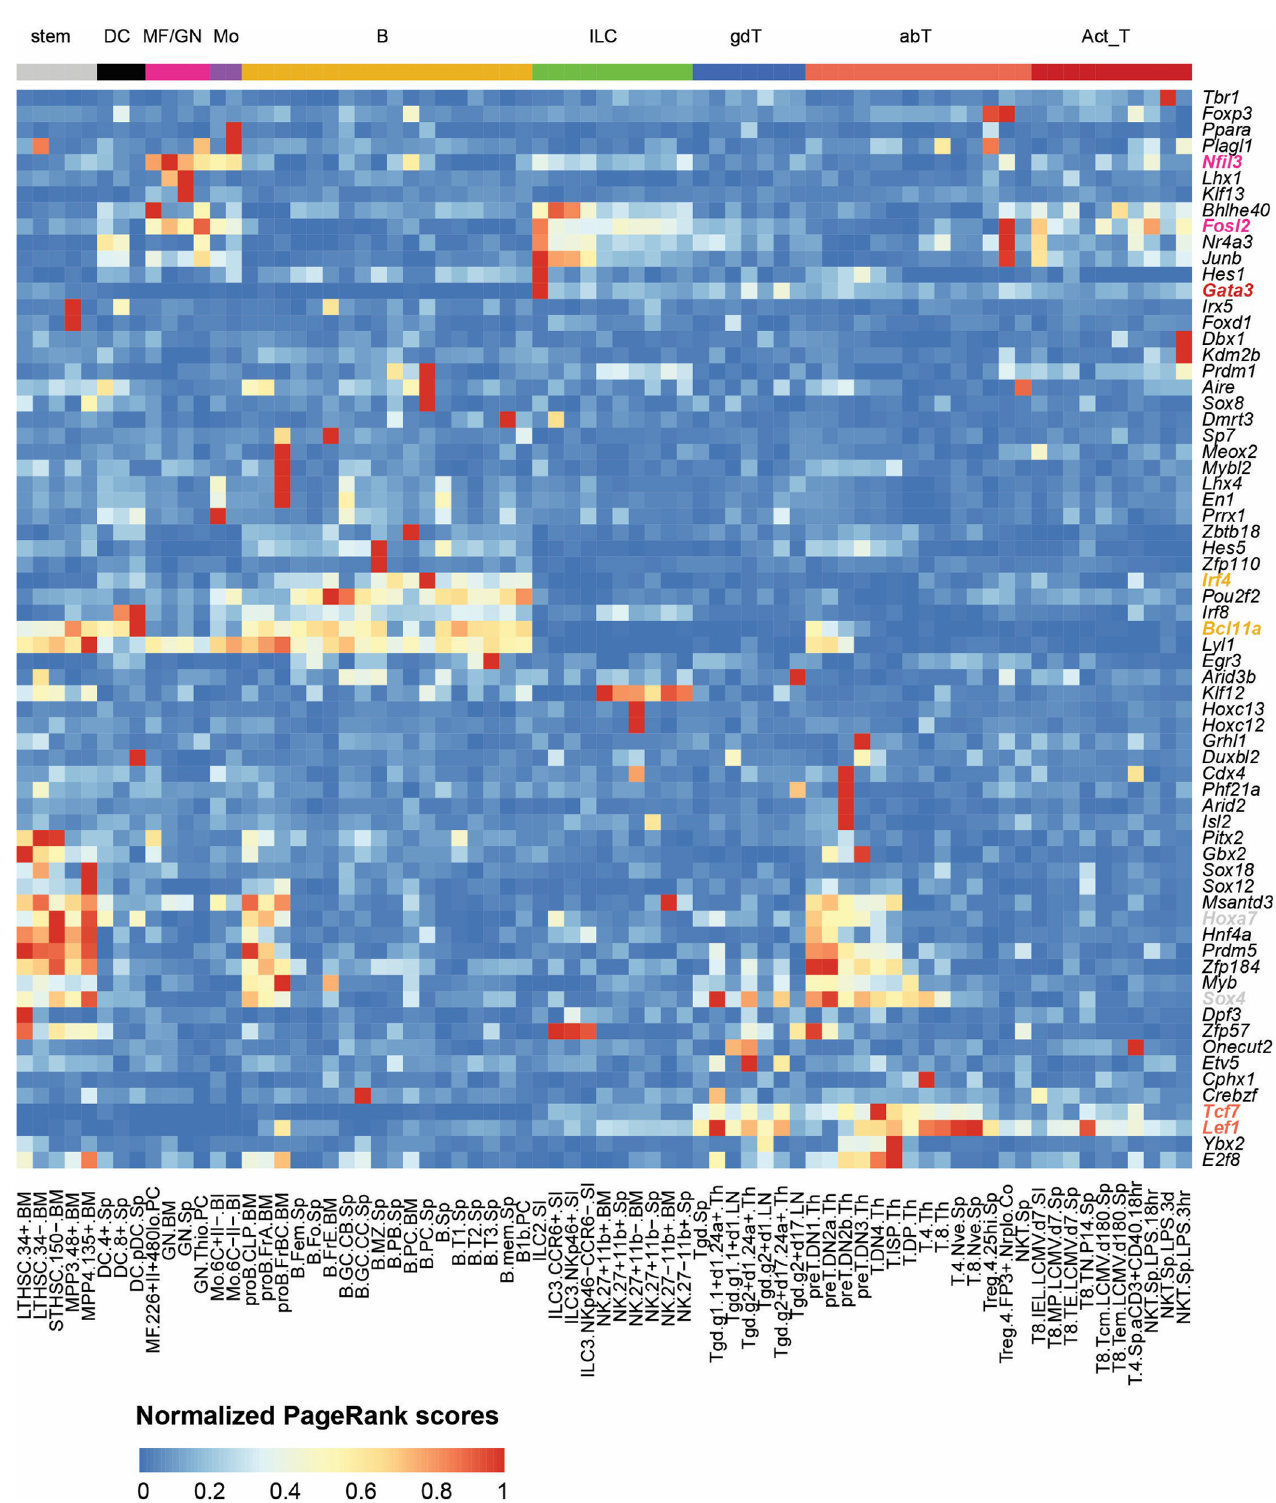
Fig 2. PageRank score is a great indicator of cell specificity. PageRank scores heatmap of 59 cell-specific TFs across 73 cell types. TFs in rows (z-normalized), cell types in columns, and color of the cell in the matrix indicates the normalized PageRank scores with red displaying high scores. Selected gene names are colored based on their cell specificity. abT, αβ T cells; Act_T, activated T cells; B, B cells; DC, dendritic cells; gdT, γδ T cells; ILC, innate lymphoid cells; MF, macrophages; GN, neutrophils; Mo, monocytes; stem, stem cells.